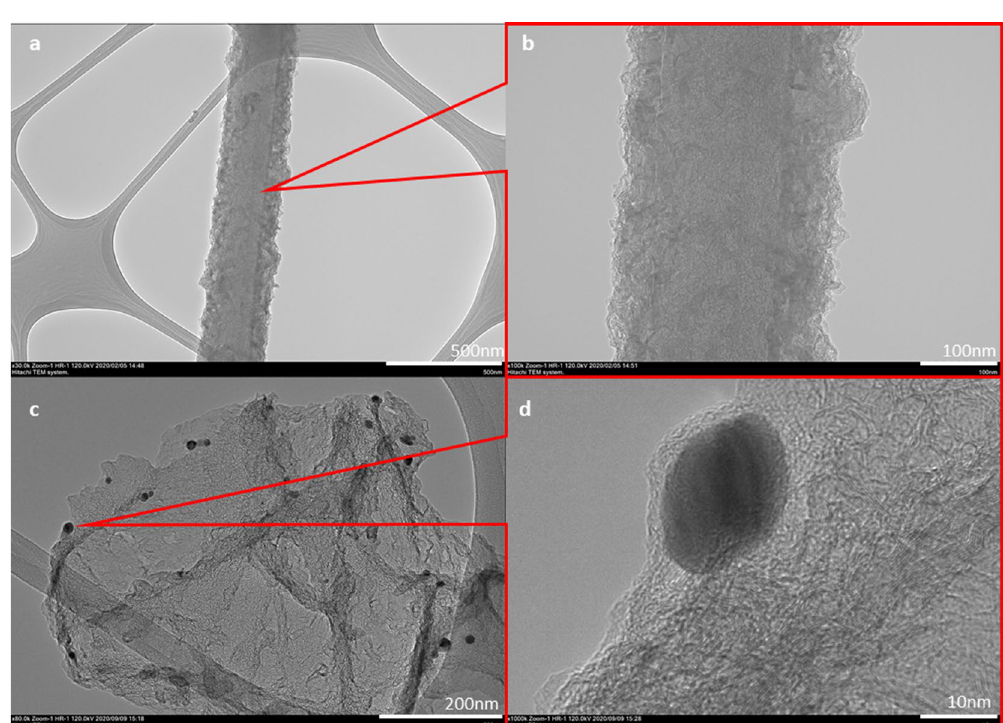
Figure 2. Typical TEM images of ( a ) LSG-NF and ( b ) LSG-NF-AgNPs, ( c , d ) shows high magnification TEM images of LSG-NF and LSG-NF-AgNPs,